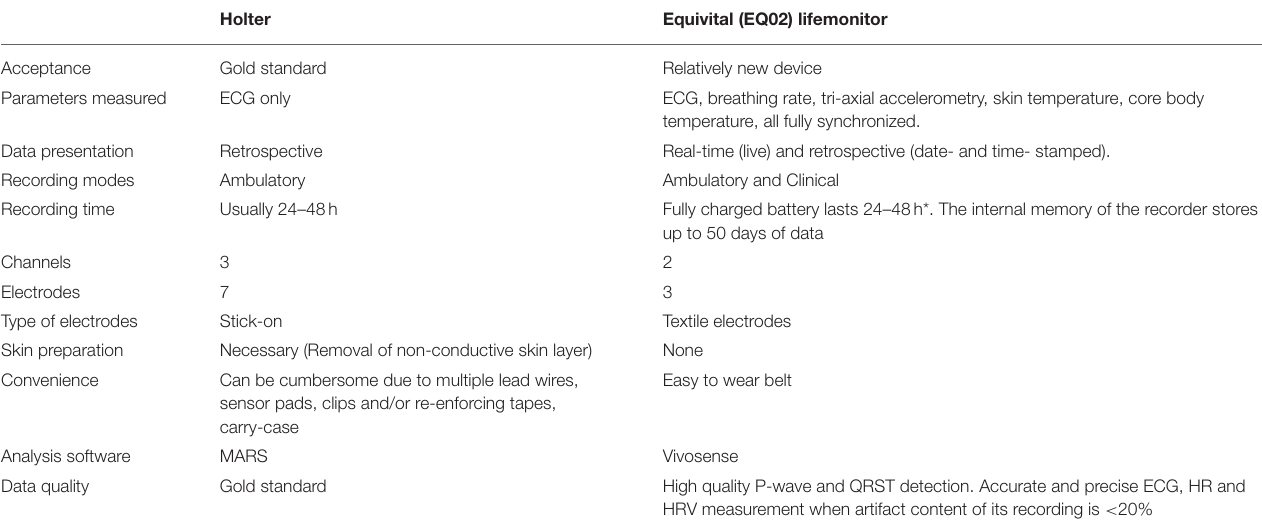
TABLE 1 | Technical characteristics of the EQ02 and Holter